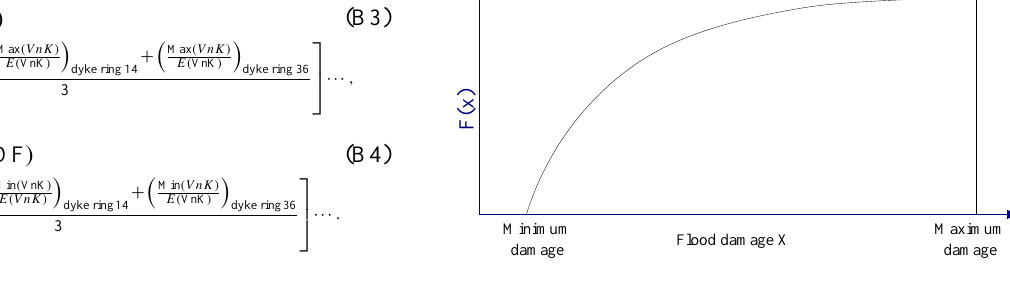
Fig. E1. A conceptual sketch of cumulative bounded distribution